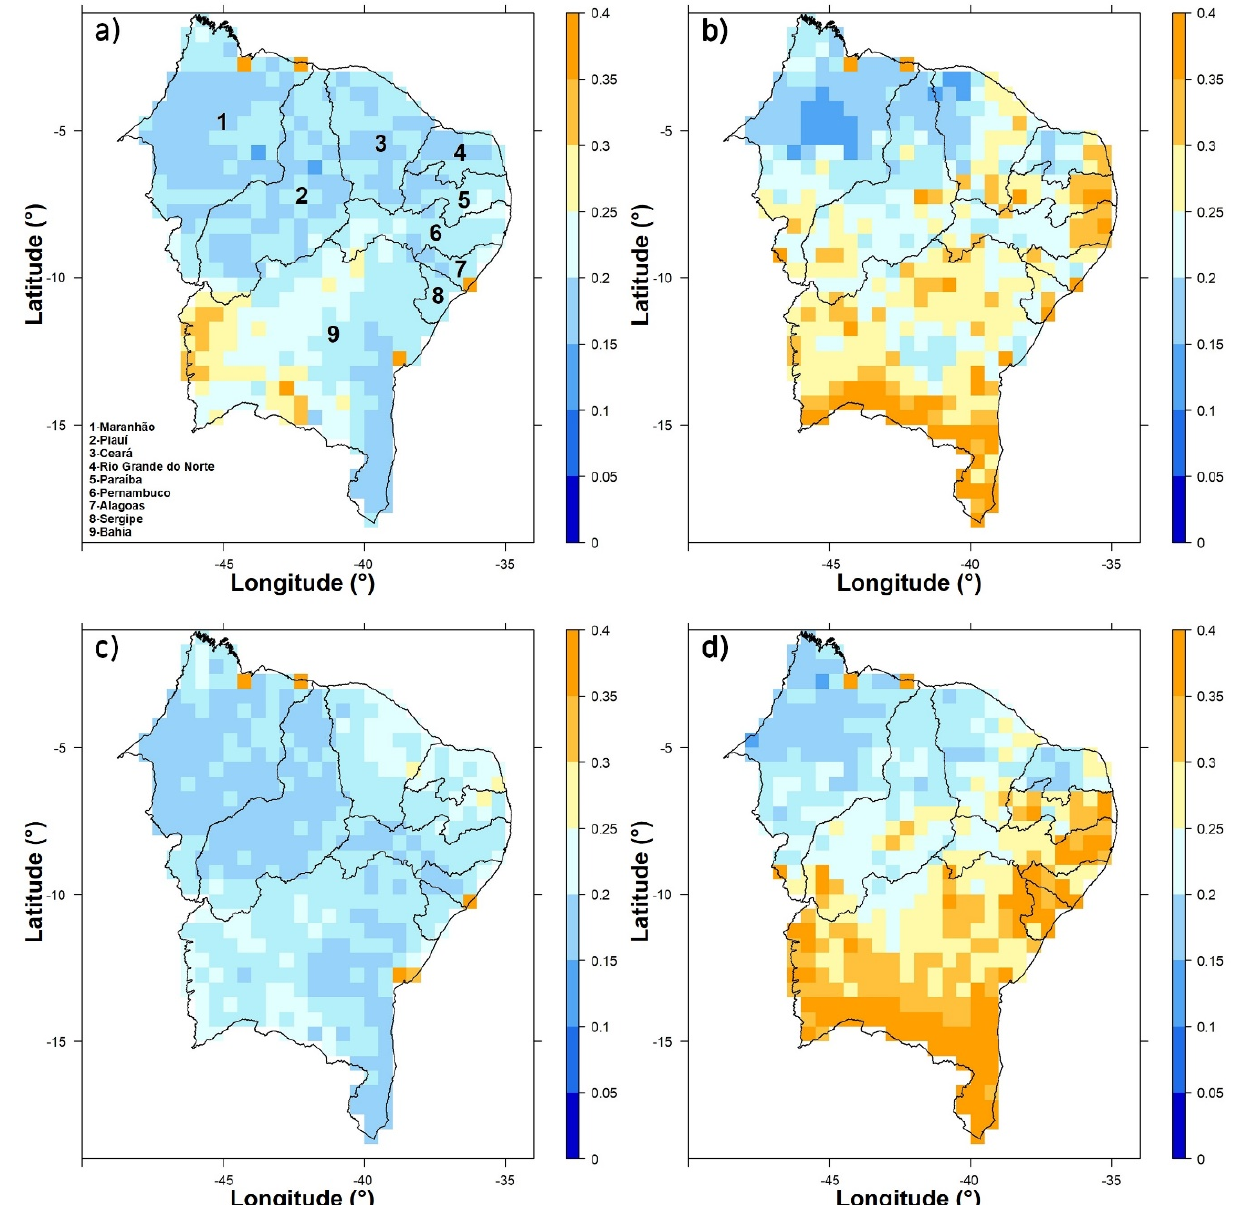
Figure 8. Brier score (BS) for forecasts below (left) an above (right) the normal for the NMME ( a , b ) and the EmpM ( c , d ).